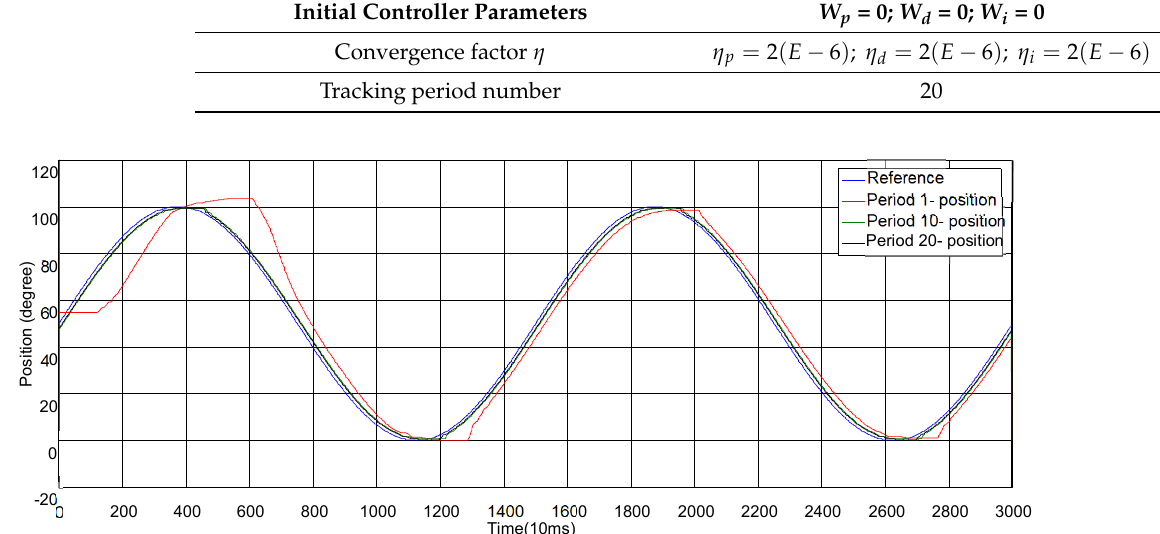
Figure 11, and Figure 12 is the tracking of the 20-period error convergence curve.